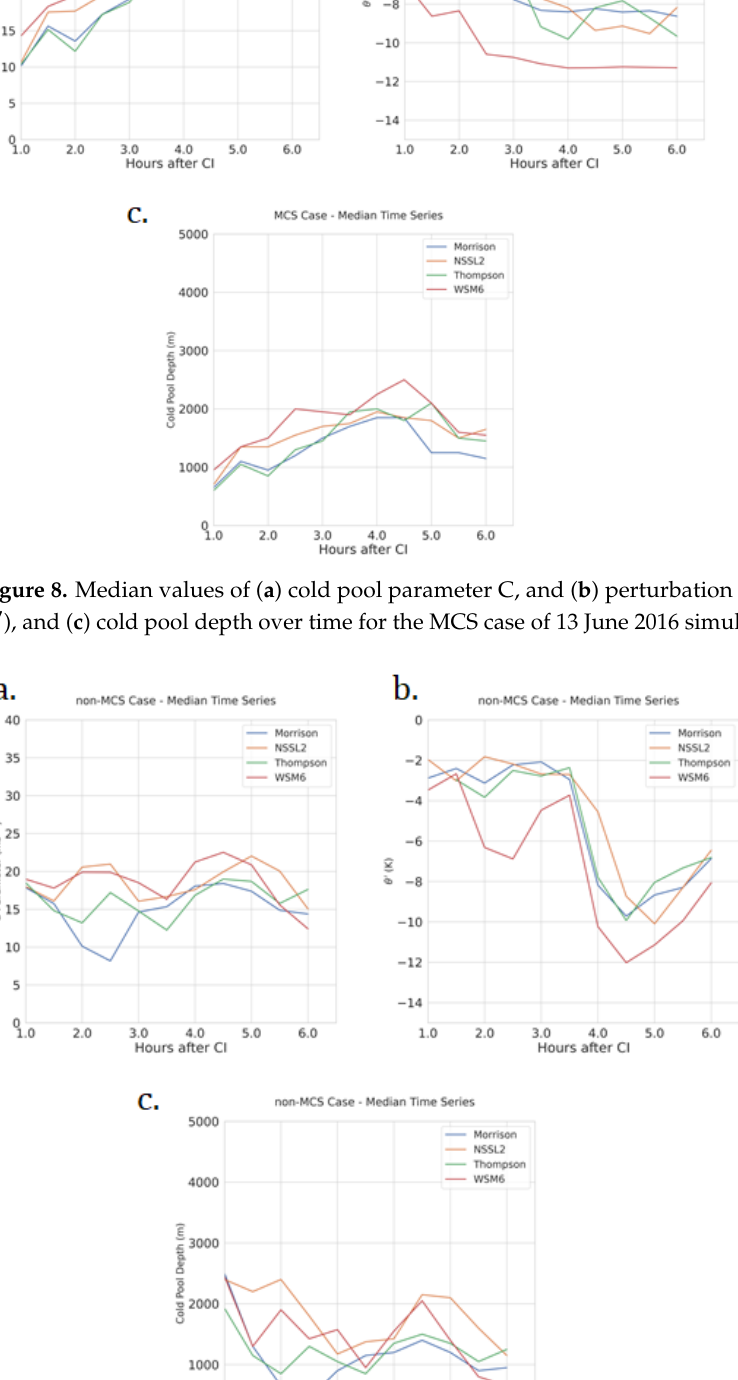
Figure 10. As in Figure 6, but for a non-MCS event on 8 August 2016, four hours after convective initiation. Images are 12-h WRF forecasts valid at 0000 UTC.